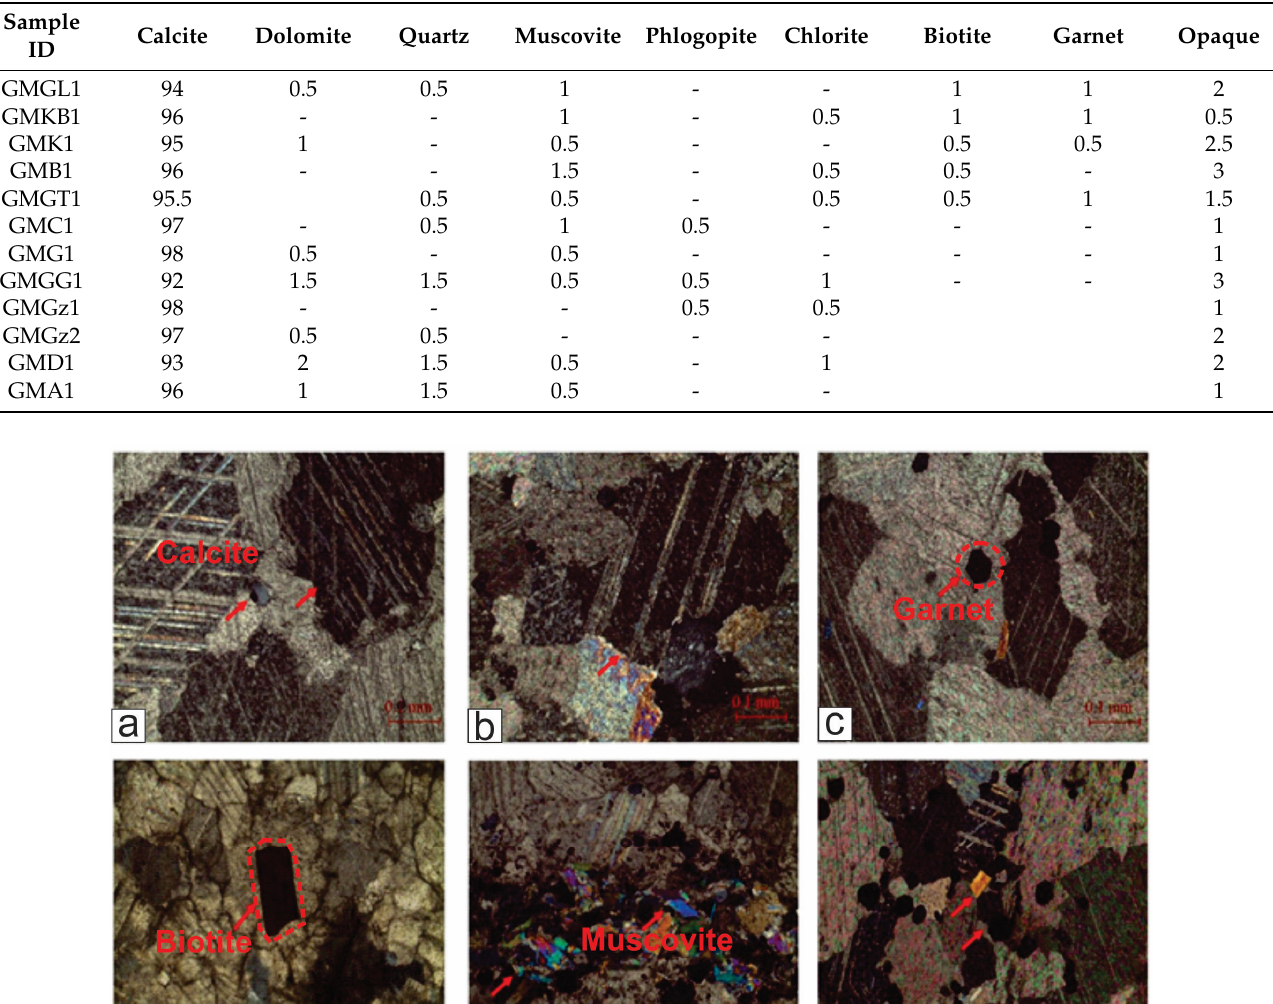
Table 1. Modal mineralogy (Vol. %) of Gahirat Marble.